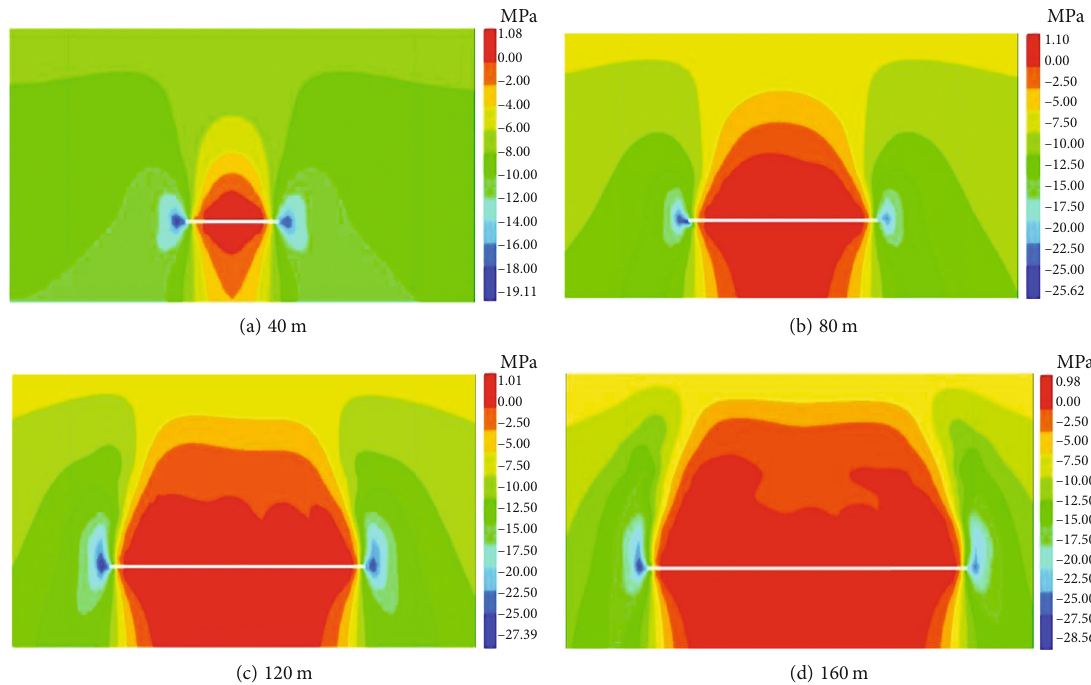
Figure 4: Distributions of vertical stress along strike direction at di ff erent advancing distances.